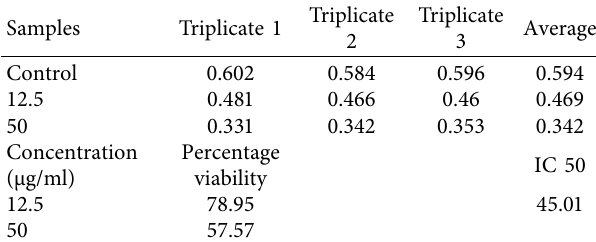
Table 1: Effect of Ag-NPs concentration on bacterial cell